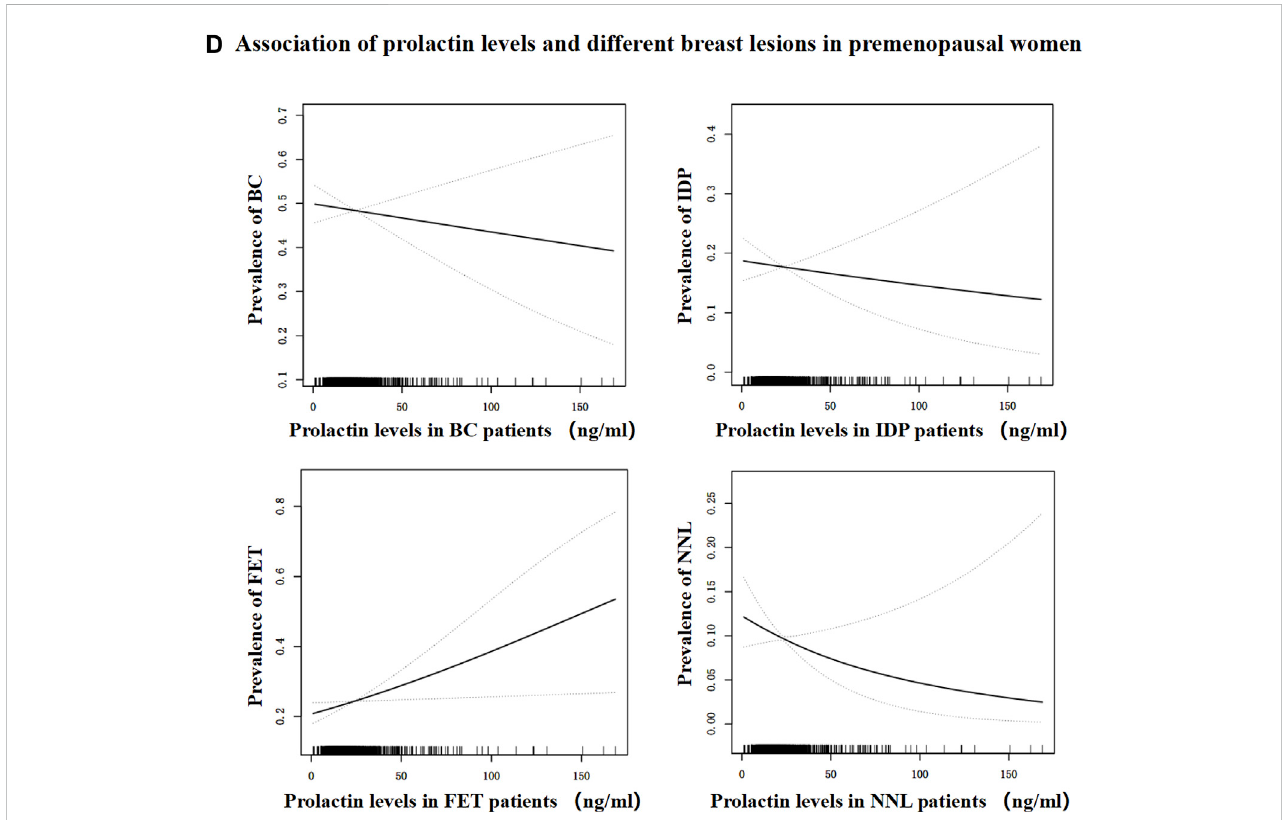
FIGURE 2 (A) Proportion of hyperprolactinemia in BC (Breast cancer), IDP (Intraductal papilloma) and NNL (Non-neoplastic lesion, including breast cyst, usual ductalhyperplasia,sclerosingadenosis,lipomaandductalectasia)hadnosigni fi cantdifference.FET(Fibroepithelialtumour)wassigni fi cantlyhigherthanNNL (40.24%vs.27.17%, p < 0.05); (B) Averageprolactin levels inBC(Breastcancer),IDP (Intraductalpapilloma) andNNL(Non-neoplasticlesion)hadnosigni fi cant difference. FET (Fibroepithelial tumour) was higher than NNL (25.93 ng/mL vs. 21.42, p < 0.05); (C) Proportion of hyperprolactinemia and average prolactin levelswerenosigni fi cantlydifferentbetweenmalignantandbenignlesions; (D) Theassociationbetweenprevalenceofdifferentbreastdiseasesand prolactin levels, prolactin level only exhibited steady ascending tendency for positive correlation with FET. The solid line and dashed line represent the estimated values and their corresponding 95% con fi dence